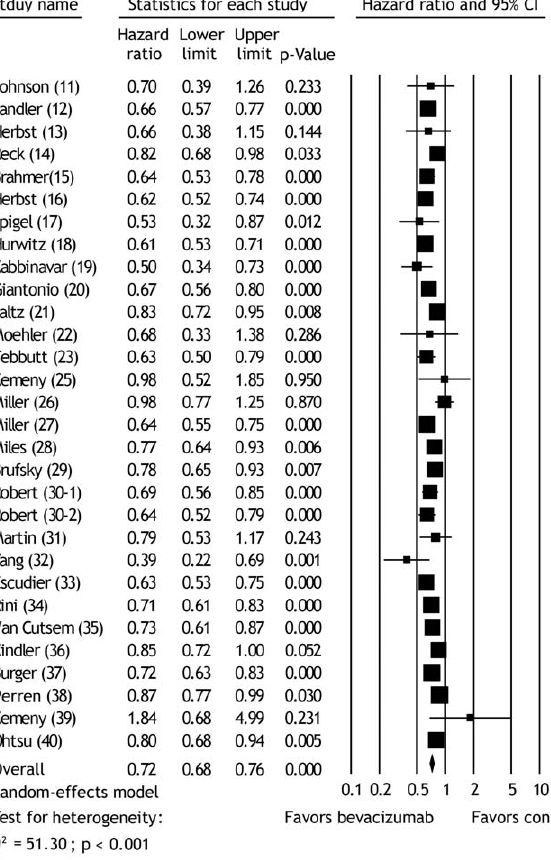
Figure 2. Meta-analysis of the hazard ratios of progression-free survival between bevacizumab and control therapy using random effect model. Bars, 95% confidence intervals (CI) of hazard ratio in patients receiving bevacizumab versus con- trols . The areas of the squares are proportional to the weights used for combining the data. The center of the lozenge gives the combined hazard ratio. The hazard ratio was considered statistically significant if the 95% CI for the overall hazard ratio did not overlap